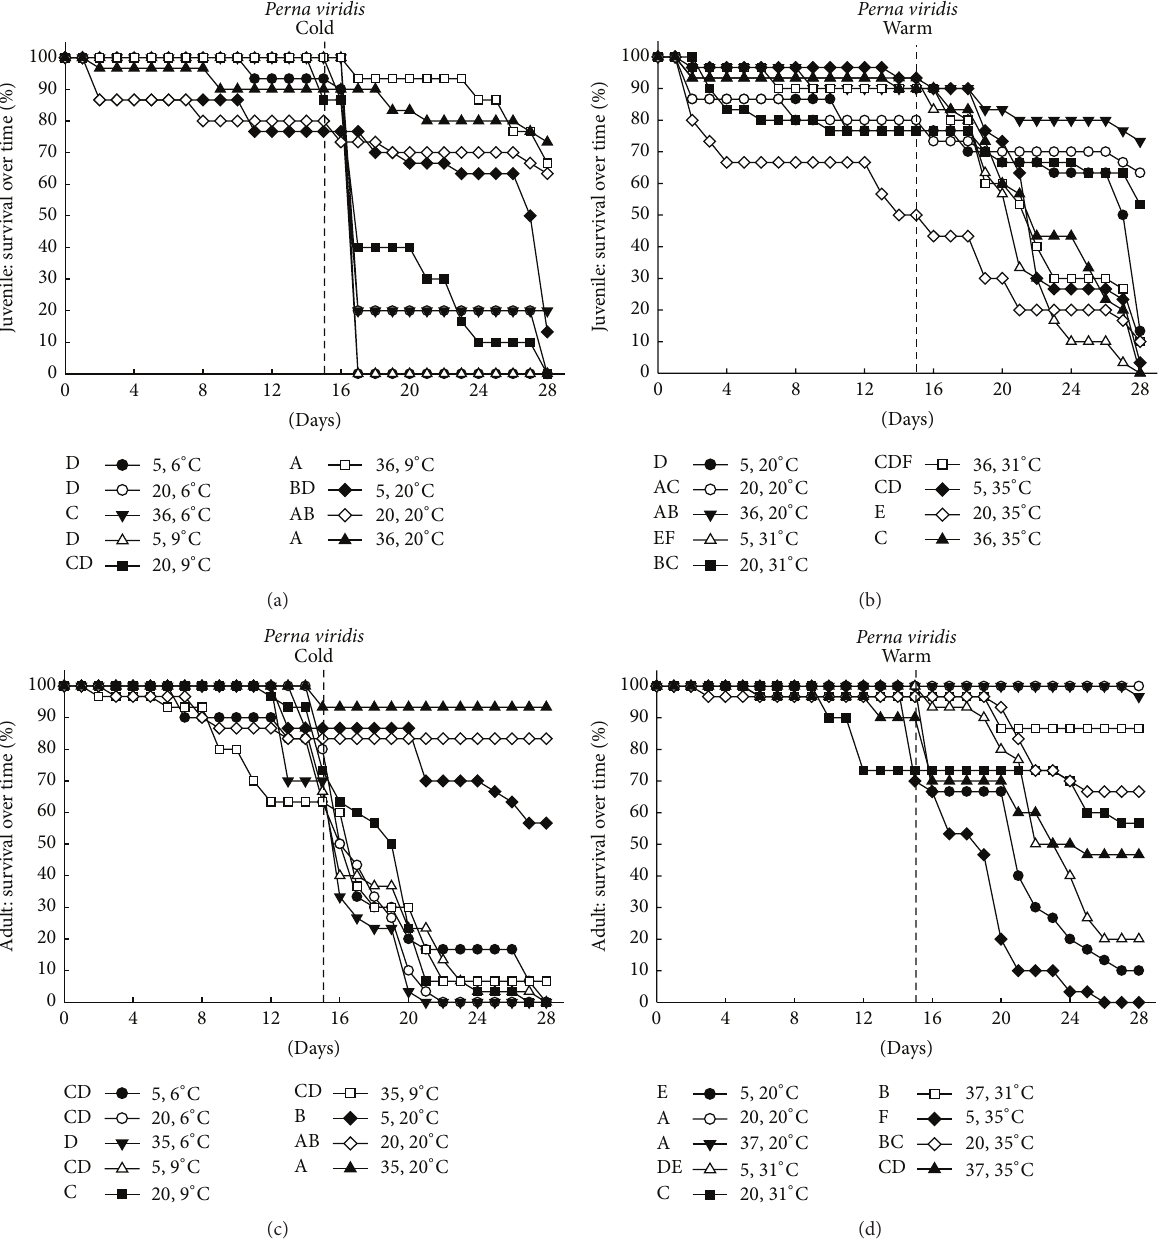
Figure 3: Survivorship curves over 28 days for Perna viridis in the temperature-salinity interaction experiments. (a) Juvenile, cold experiment (temperatures: 6, 9, and 20 ∘ C; salinities: 5, 20, and 36 ppt); (b) juvenile, warm experiment (temperatures: 20, 31, and 35 ∘ C; salinities: 5, 20, and 36 ppt); (c) adult, cold experiment (temperatures: 6, 9, and 20 ∘ C; salinities: 5, 20, and 35 ppt); and (d) adult, warm experiment (temperatures: 20, 31, and 35 ∘ C; salinities: 5, 20, and 37ppt). Upper case letters indicate significant differences of 𝑝 ≤ 0.05 among treatments using survivorship analysis. Dotted lines show the end of the 15-day temperature adjustment